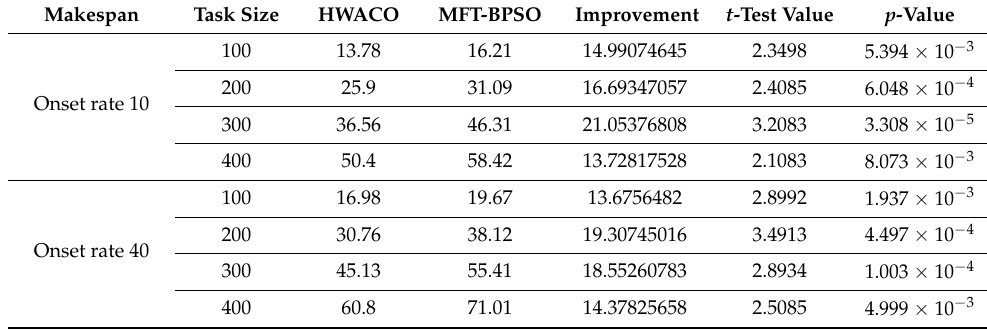
Table 5. t -Test for makespan between HWACO and MFT-BPSO.